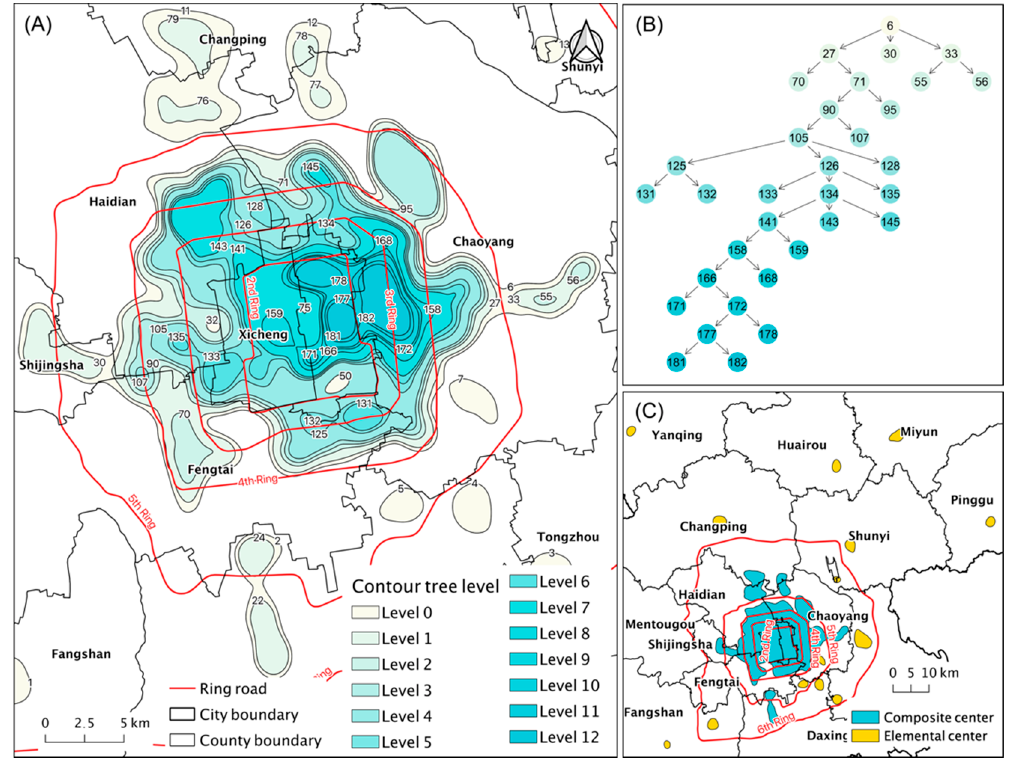
Figure 9. Spatial distribution structure of the accommodation and catering industry in Beijing. ( A ) Simplified contour line; ( B ) Structure of the main tree; ( C ) Composite center and single center.